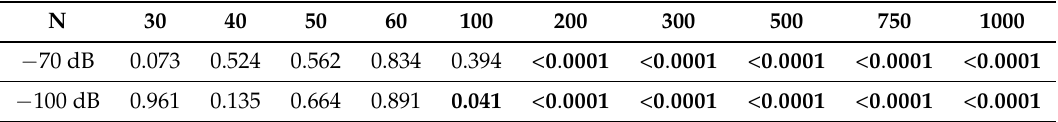
Figure 8. AUC as a function of the number of training data samples, for microwave scattering data with a high amplitude noise floor at − 70 dB. Table 2. Results of one-tailed Student’s t -test. Values in bold are statistically significant ( p <